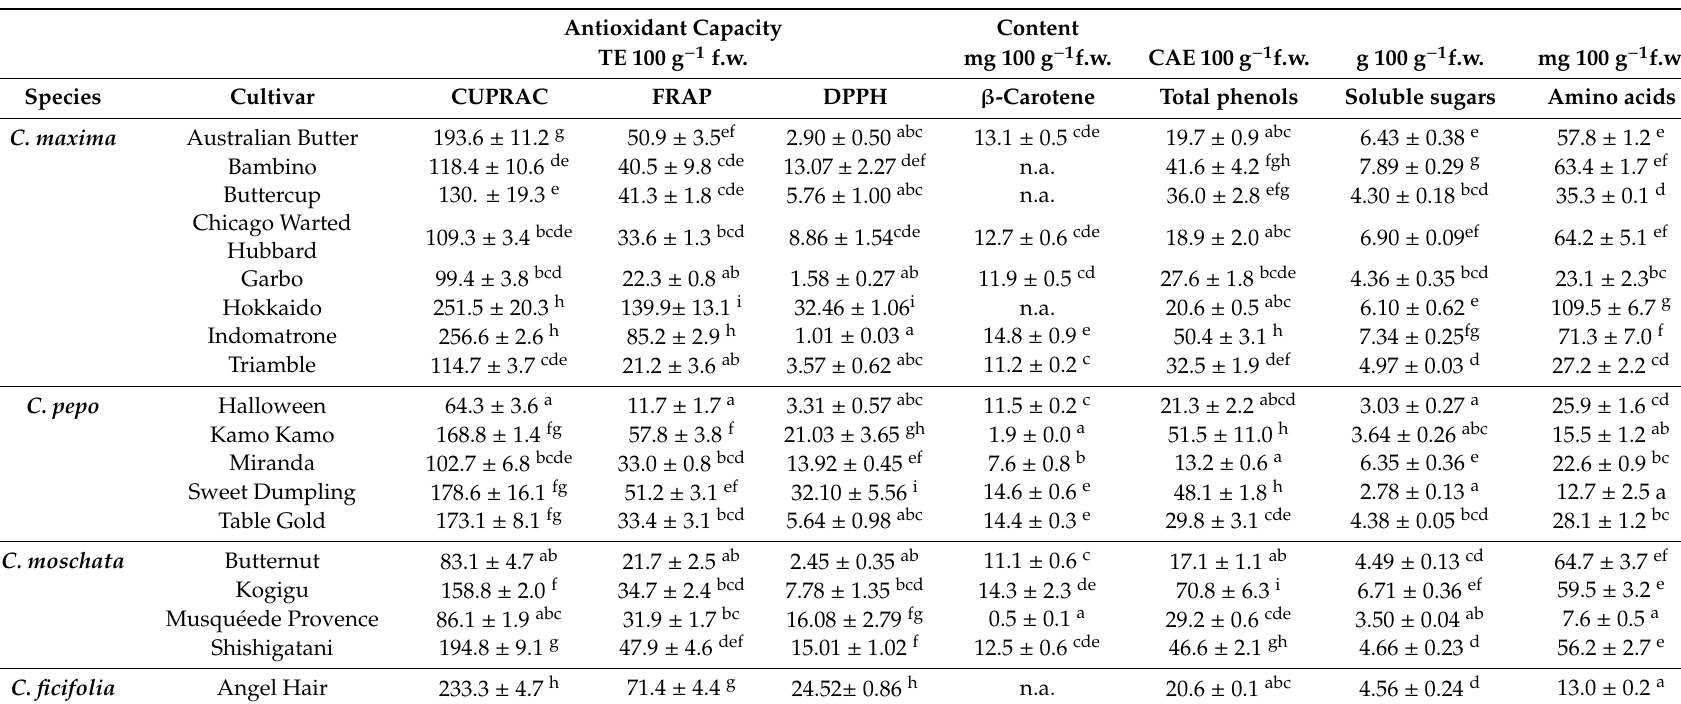
Table 1. Antioxidant capacity and the content of β -carotene, phenolic compounds, soluble sugars, and free amino acids in the pulp of 18 Cucurbita